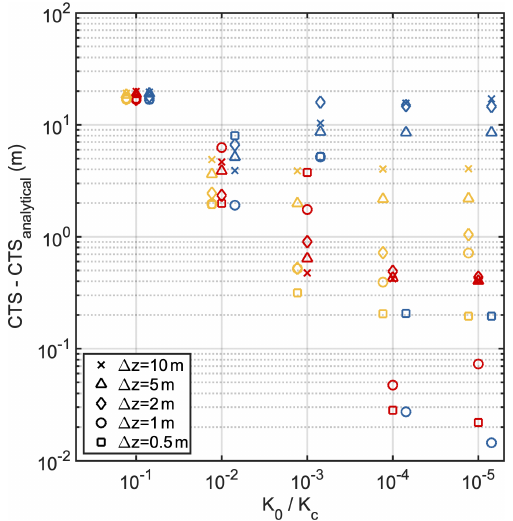
Figure 1. Difference of simulated steady-state CTS elevations to the analytical CTS elevation for different values of the temperate ice conductivity, K 0 , for the polythermal-slab experiment. The analyti- cal CTS elevation is 18.95m. The different conductivity models are shown as harmonic mean (yellow), geometric mean (red), and arith- metic mean (blue). Results of different models are slightly shifted on the x axis so as not to overlay each other. The dashed black line indicates the CTS elevation of the analytical solution derived for K 0 = 0kgm − 1 s − 1 .